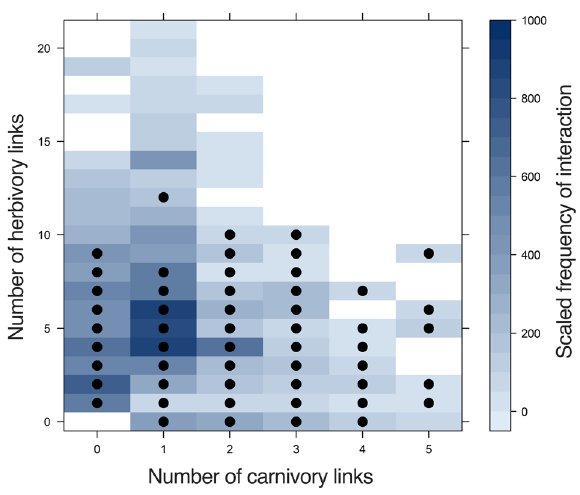
Fig. 4 Link plasticity among carabid species. Density plot showing the relationship between the number of herbivore and carnivore links across all networks. Each blue-shaded square indicates the instances that an omnivore carabid had a particular number of links to gastropods and to weeds, with the depth of the blue shading indicating the frequency of observation across all networks, scaled between 0 and 1000. Some networks contained carabids acting as pure herbivores or carnivores in the networks, but most contained omnivores. A fi lled, black circle is used to denote the link composition observed in different networks for the most common carabid species, Pterostichus melanarius , which in some networks appeared as either an herbivore (having links only to weeds) or a carnivore (having links only to gastropods), but more often acted as a fl exible